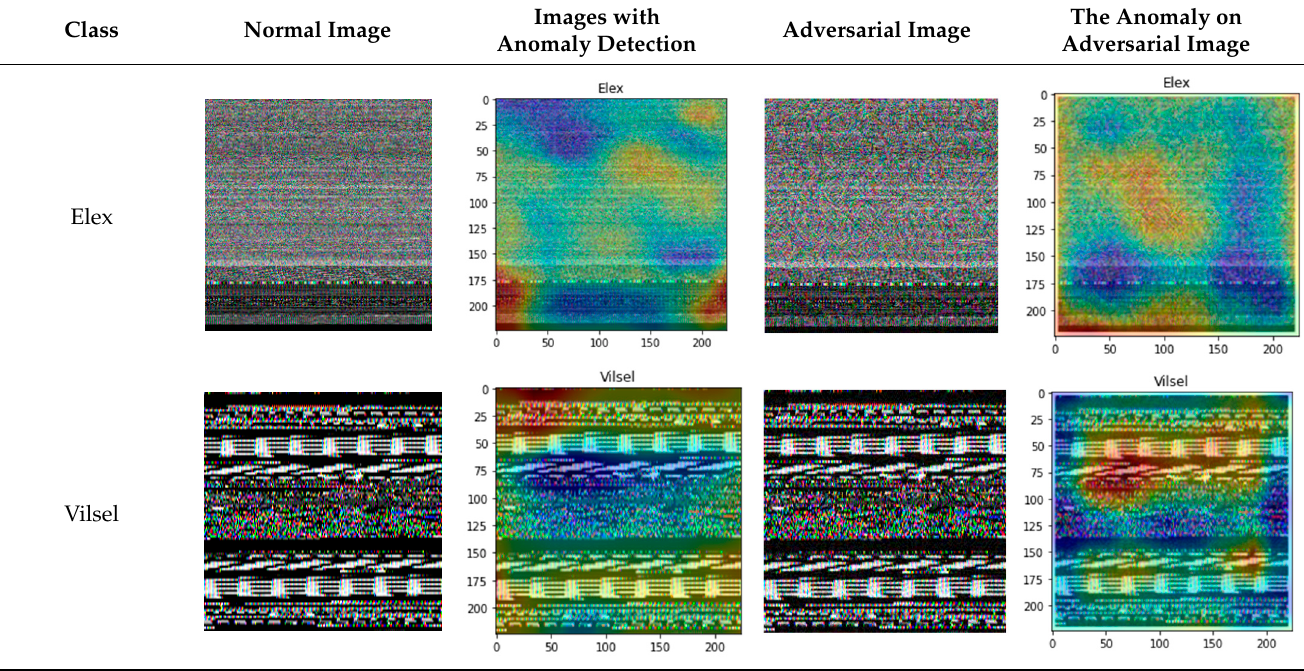
Table 6. Anomaly detection for normal image and adversarial image.